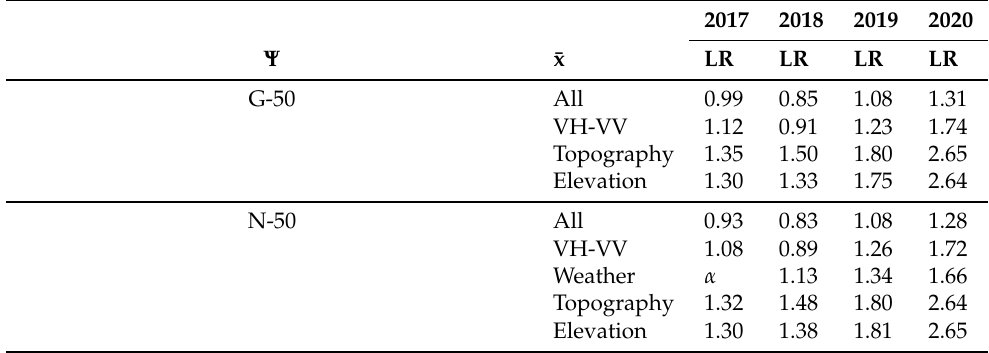
Table A1. Comparisons of RMSE results based on simple Linear Regression and data from all